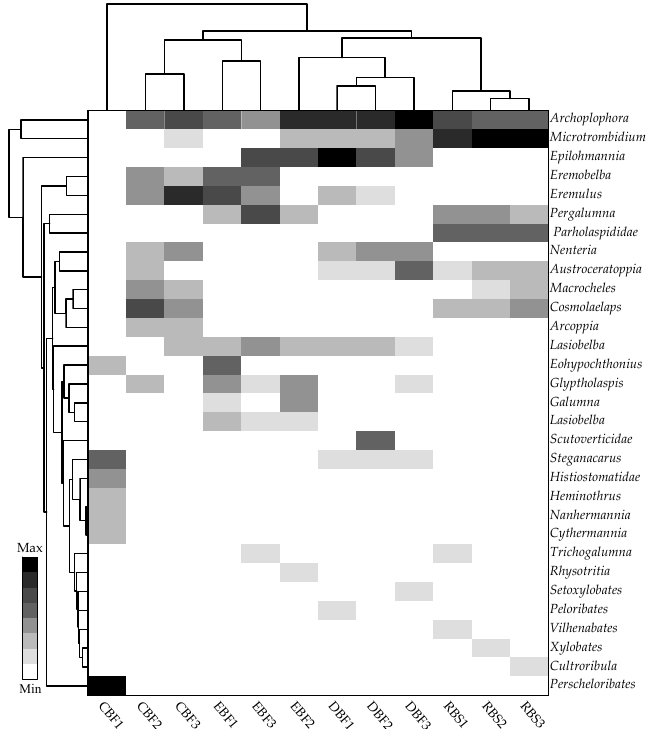
Figure 4. Two-way cluster analysis of the soil mites’ communities under different vegetation vertical zones in in the study area.